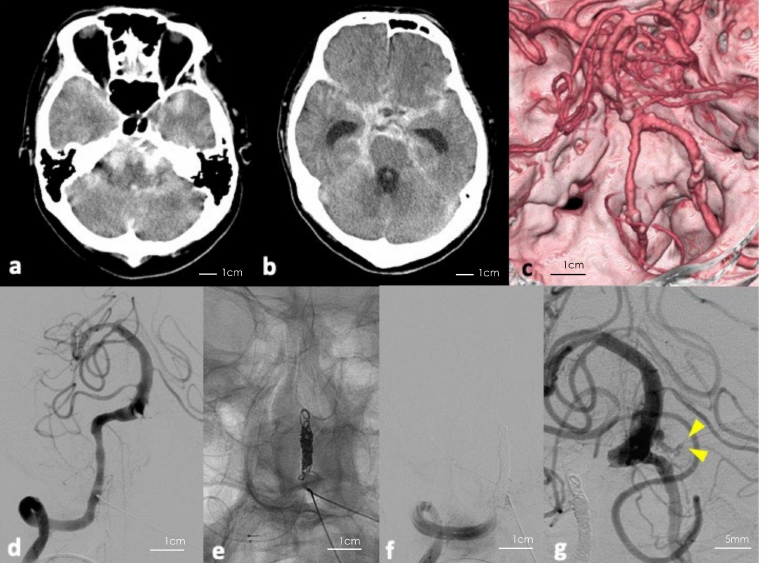
Figure 1. ( a , b ) Initial computerized tomography (CT) of the head showing massive subarachnoid hemorrhage. ( c ) Three-dimension reconstructed CT angiography of the head showing no apparent saccular aneurysm. ( d – f ) Digital subtraction angiography (DSA) of the right vertebral artery before and after parental artery occlusion using coils. ( g ) Follow-up DSA showing blood flow in the aneurysm including the bleb (yellow arrowheads indicating the